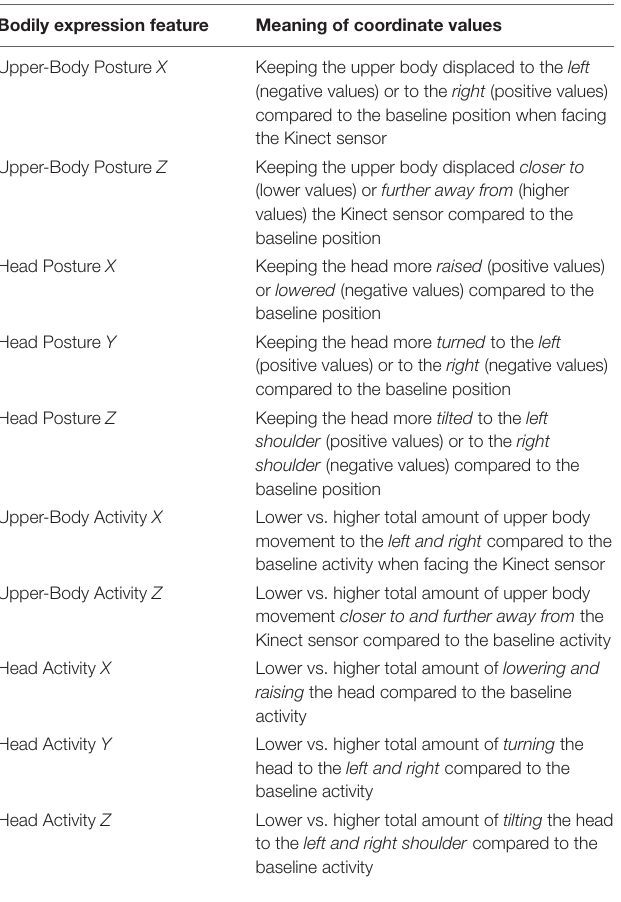
TABLE 1 | Descriptions of bodily expression features and meanings of correspondent coordinate values. Bodily expression feature